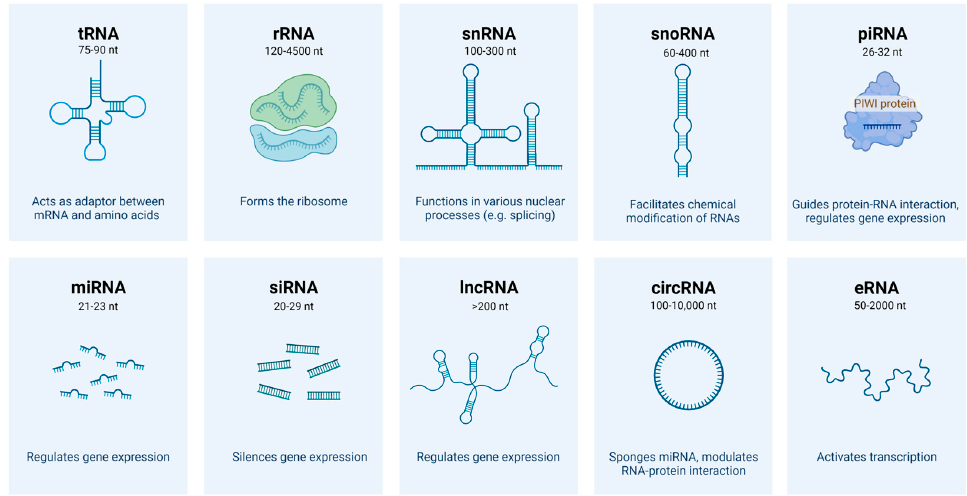
Figure 1. Schematic representation of major non-coding RNA types produced in cells. Size of each ncRNA type and main functions are included in the same panel as well. The figure is created with Biorender (Biorender.com (accessed on 28 January 2022)).